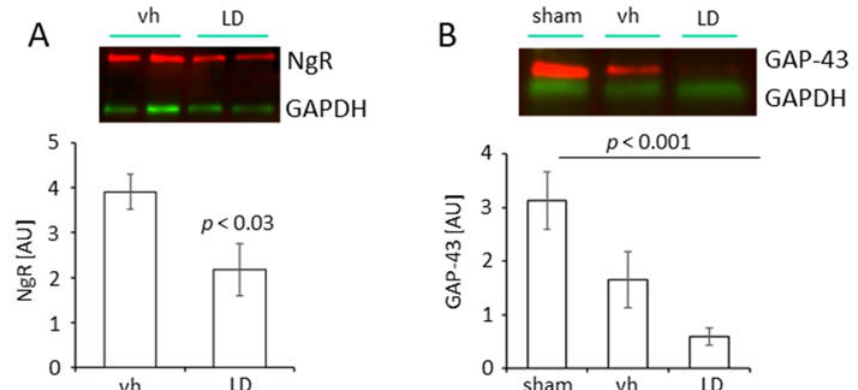
Figure 4. Regulation of Nogo A receptor (NgR) and Growth Associated Protein 43 (GAP 43) following treatment with levodopa. ( A ) Levels of NgR in the proximal peri-infarct area of vehicle (saline; n = 8) and levodopa-treated rats (LD 20 mg/kg; n = 8) 14 days after tMCAO. Data are presented as mean ± SEM, statistical analysis was performed using Student ´ s t -test. ( B ) Levels of GAP 43 in the proximal peri-infarct area in sham-operated rats treated with saline ( n = 5) and rats subjected to tMCAO and treated either with saline ( n = 6) or levodopa (LD 20 mg/kg; n = 6). Statistical analysis was performed by One-way ANOVA with posthoc Bonferroni correction. p value < 0.05 was considered significant and differences are shown in respective figures.